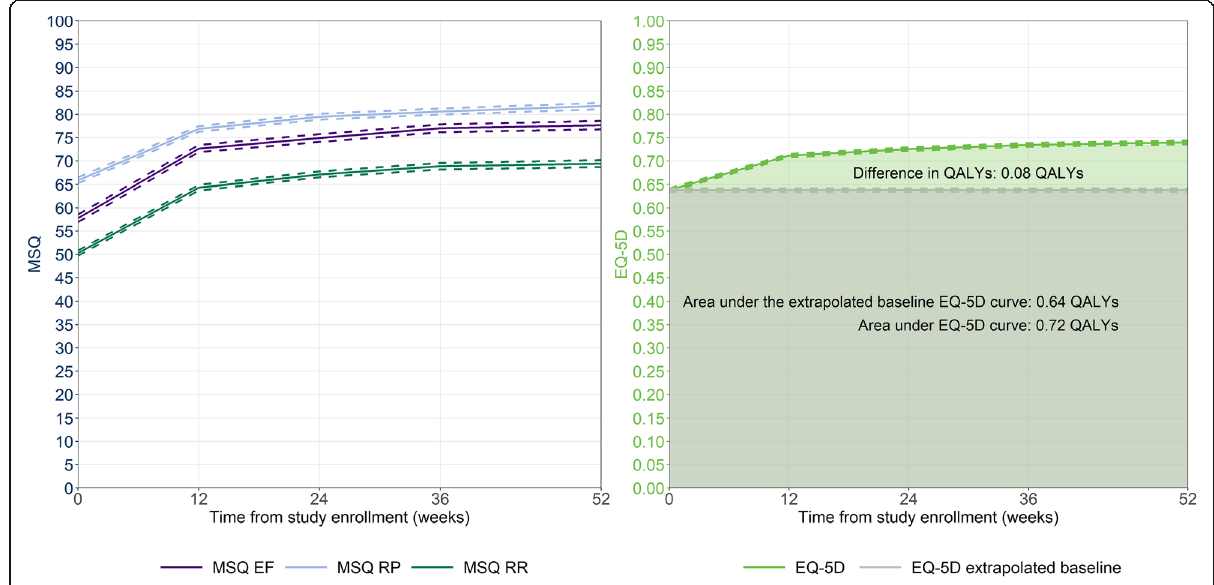
Fig. 3 MSQv2 outcomes and mapped utilities for patients in BHV3000 – 201. EF = Emotional Function, EQ-5D = EuroQoL five-dimension, MSQ = migraine specific questionnaire, QALY = quality adjusted life year, RP = Role Function-Preventive, RR = Role